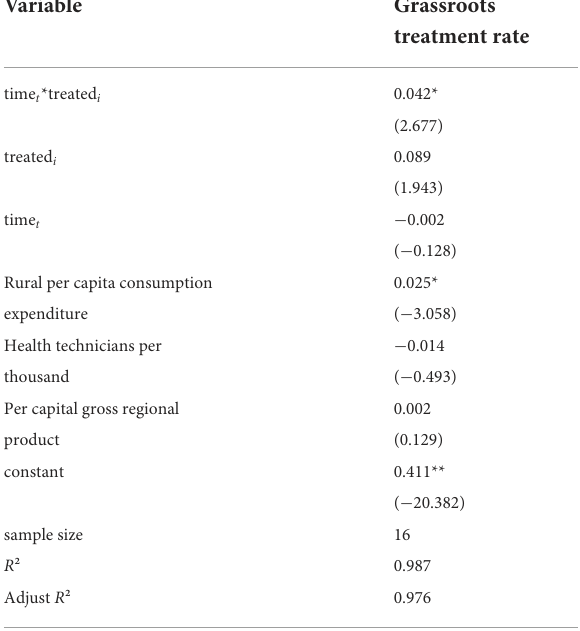
TABLE 1 Effects of GDT on primary care behavior.